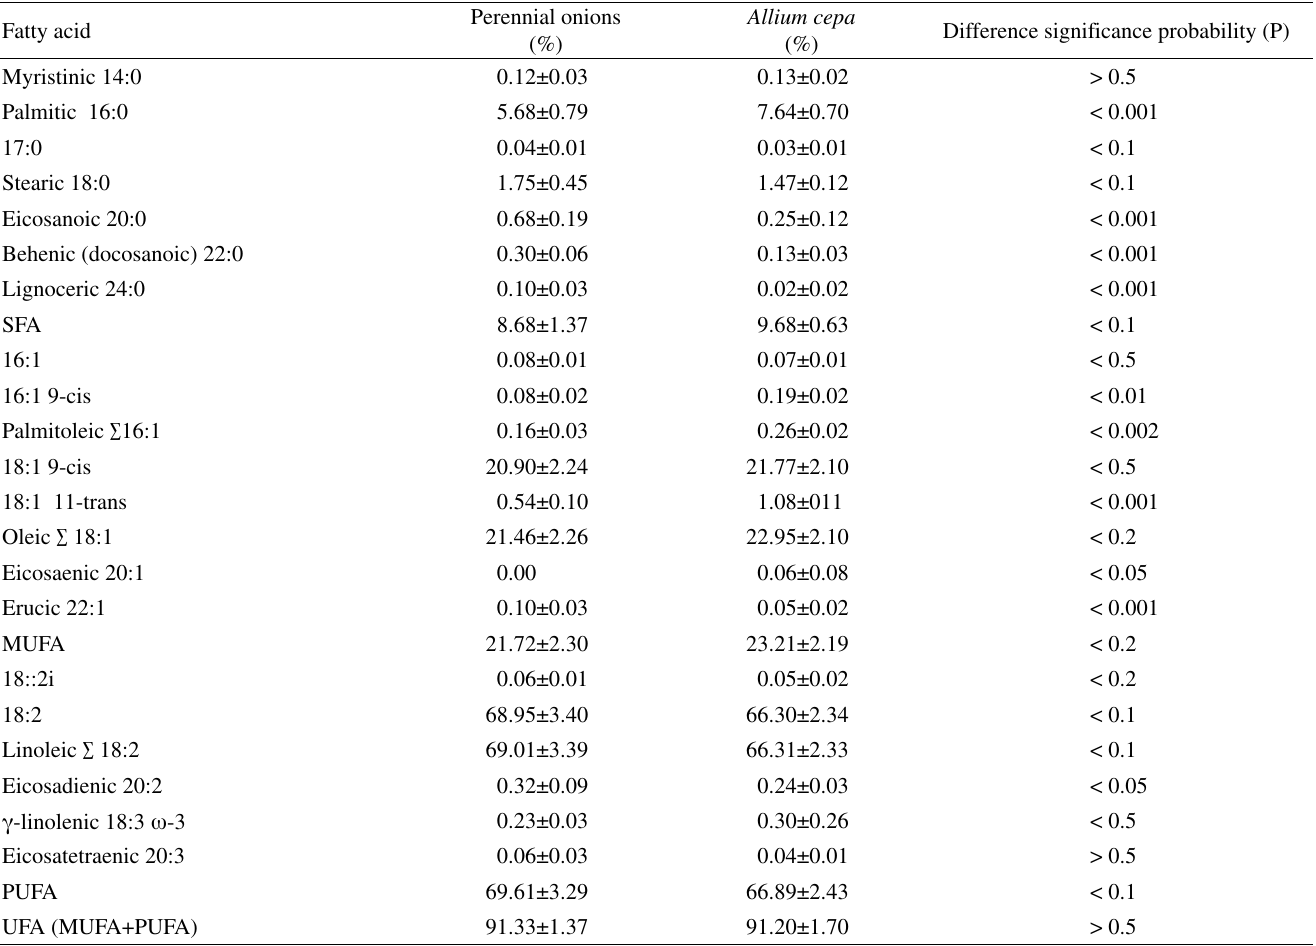
Table 5 - Mean values of fatty acids composition of oil in Allium cepa and in perennial onion species seeds